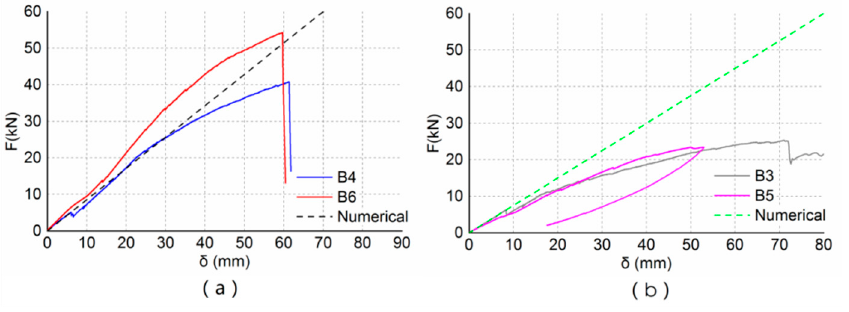
Figure 12. Comparison of experimental and numerical results. ( a ) Reinforced with two layers of CFRP sheets; ( b ) reinforced with one layer of CFRP sheet.